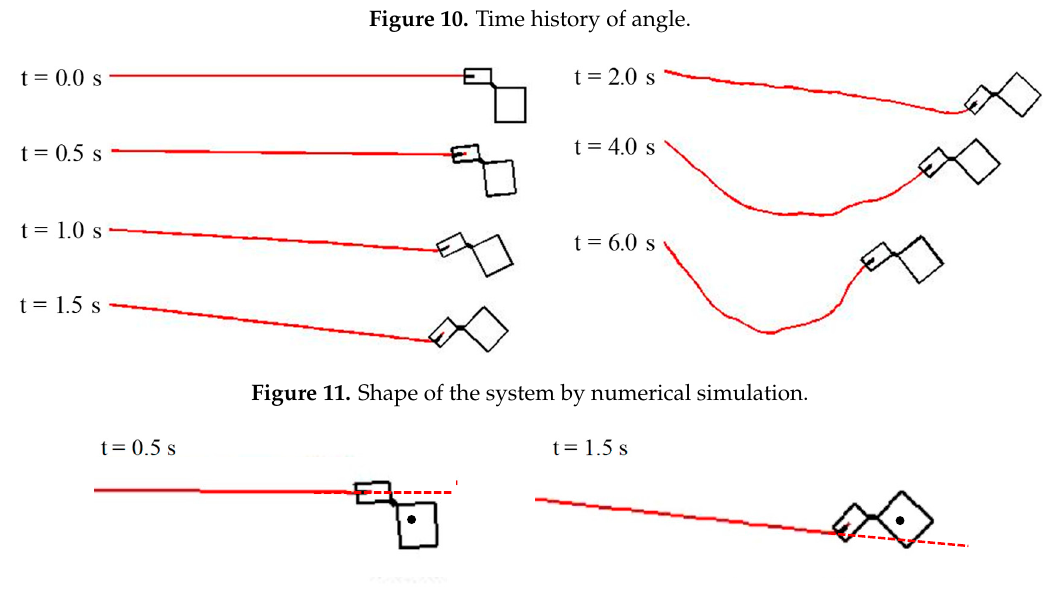
Figure 12. Relationship between the center of gravity (COG) of the TSMD and the point of action of the tension force at 0.5 s and 1.5 s.